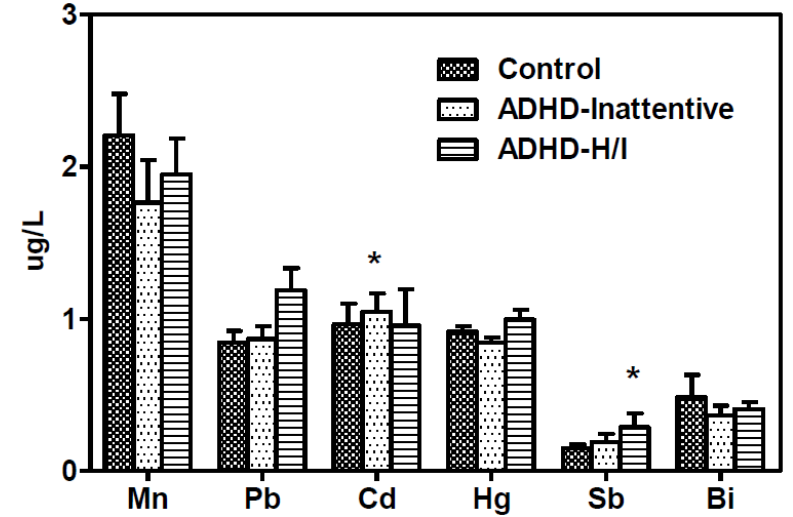
Figure 1. Urinary levels of manganese (Mn), lead (Pb), cadmium (Cd), mercury (Hg), antimony (Sb), and bismuth (Bi) of patients with ADHD inattentive type (ADHD-I), patients with ADHD hyperactivity/impulsivity type (ADHD-H/I), and healthy control subjects. Children with ADHD-I demonstrated the highest Cd ( p = 0.034) levels, and children with ADHD-H/I demonstrated the highest Sb levels ( p = 0.028).